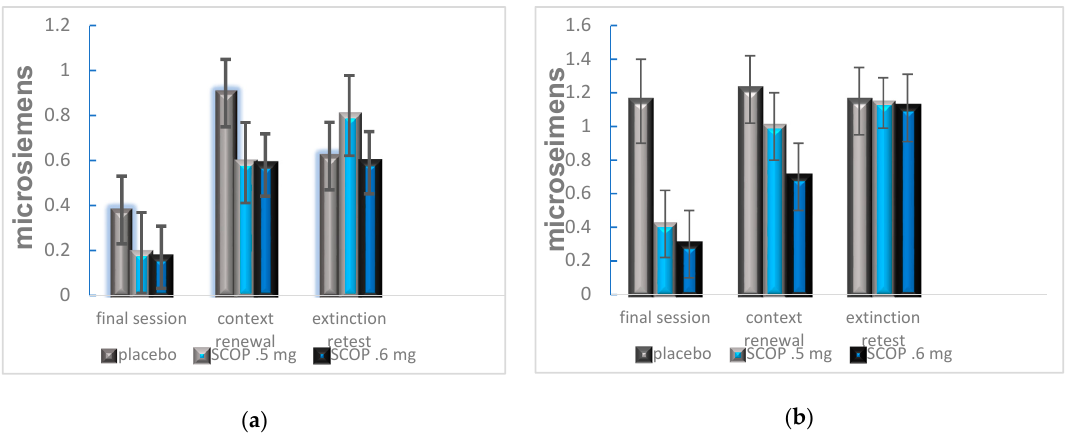
Figure 2. ( a ) Measurement of skin conductance response to CS onset during the final extinction session, context renewal test, and extinction retest. Participants who were administered 0.5 or 0.6 mg of scopolamine showed significantly lower response when the CS was presented in a novel context, indicating a lack of fear renewal ( b ) Measurement of skin conductance response to CS termination. Participants who were administered 0.6 mg of scopolamine showed significantly less response when